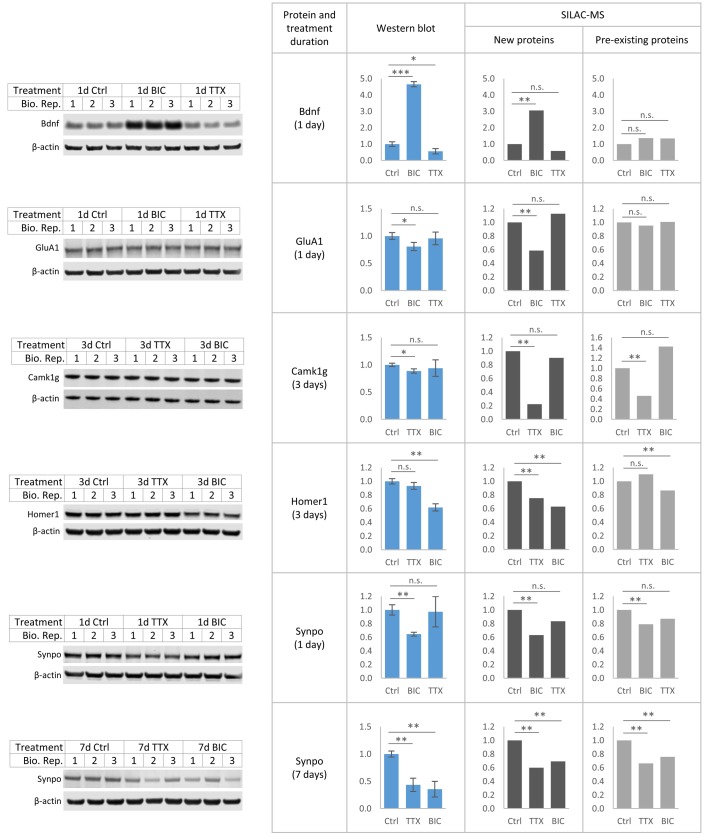
Validation of selected proteins by western blot.Western blot analysis for Bdnf, GluA1, Camk1g, Homer1 and Synpo, as well as β-actin as loading control. Treatment and treatment duration are indicated. All signals were normalized to the corresponding β-actin signals. For statistical analysis of the western blot data, a two-sided t-test was performed. ***, p<0.001; **, p<0.01; *, p<0.05; n.s., not significant. Error bars represent the standard deviation between biological replicates (N = 3). Quantitative results of the western blot analysis (blue) are in excellent agreement with the SILAC-MS results for new proteins (dark gray) and pre-existing proteins (light gray). For SILAC-MS analysis: **, FDR < 1%; n.s., not significant.